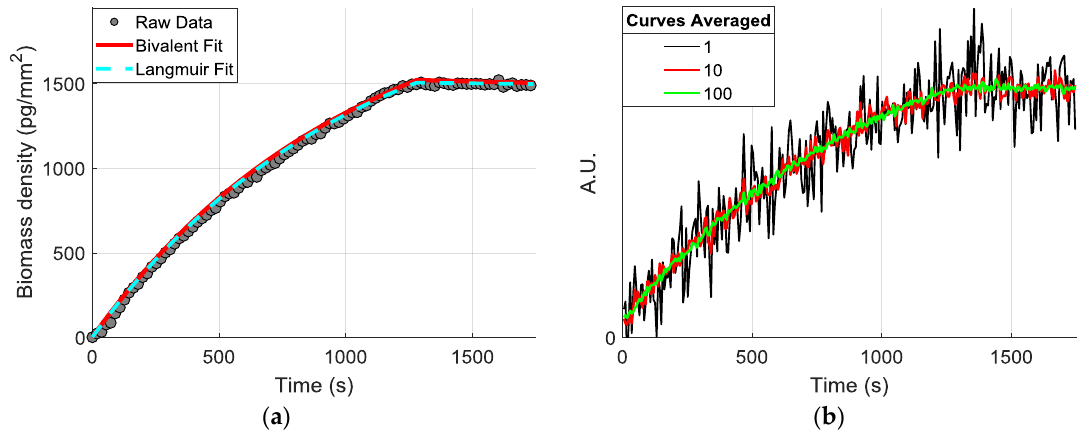
Figure 8. ( a ) Example raw data from obtained is shown with a Bivalent and Langmuir fit, with R 2 values of 0.998 and 0.993, respectively. ( b ) The theoretical curves were created from the extracted coefficients with an additive Poisson noise.